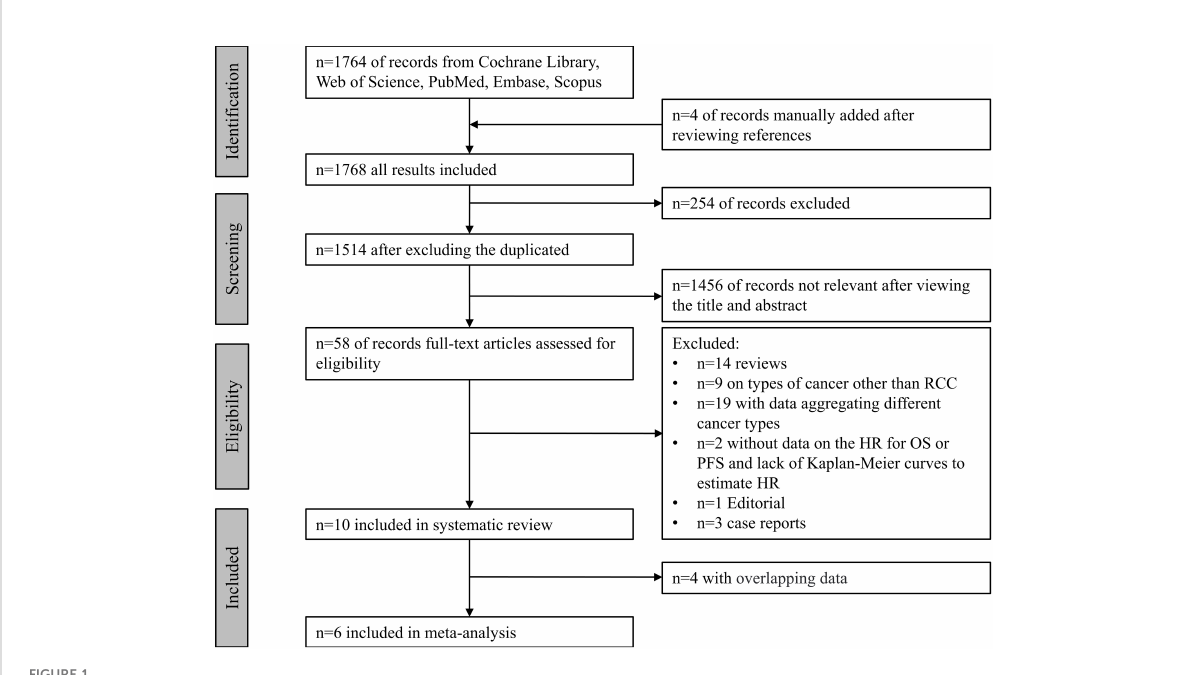
FIGURE 1 Flow diagram of included and excluded